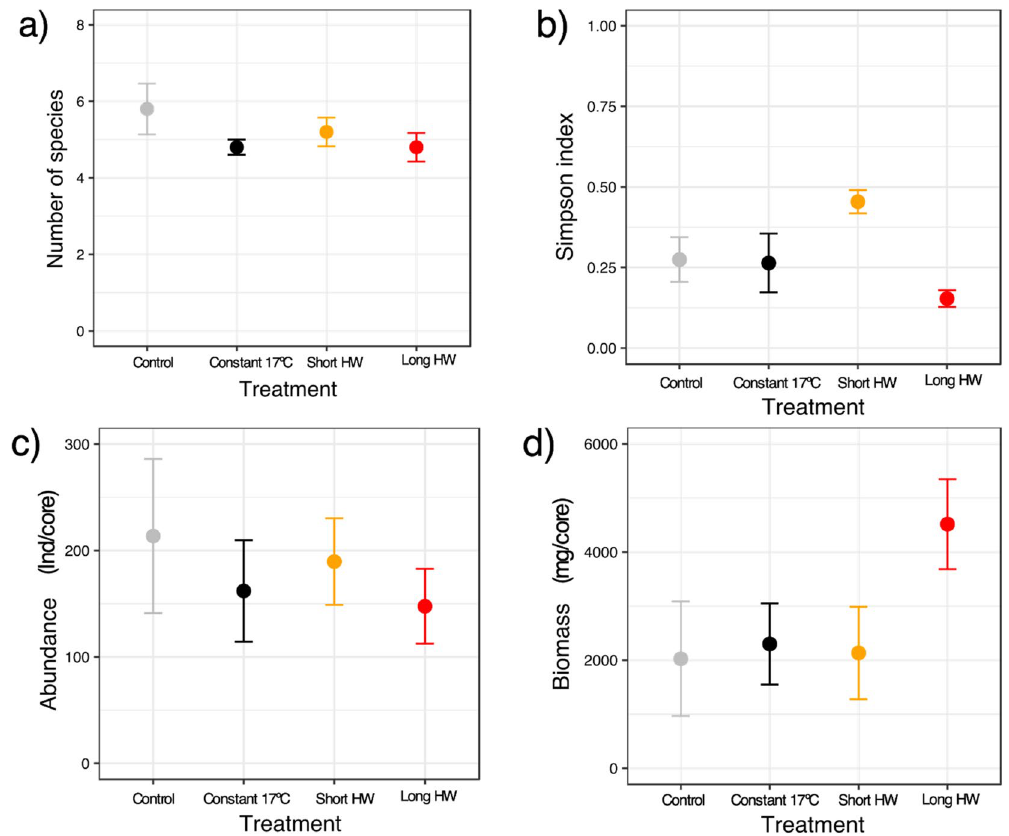
Figure 4. Macrobenthic community data (mean and standard deviation) for the initial control samples and each temperature treatment (symbols’ colours), considering ( a ) species number, ( b ) Simpson index measured with biomass, ( c ) community abundance (number of individuals per core), ( d ) community biomass (mg ash- free dry mass—AFDM per core). Graphs done with ggplot2 from R software (https:// ggplo t2. tidyv erse. org) and figure compiled with INKSCAPE (https:// inksc ape.